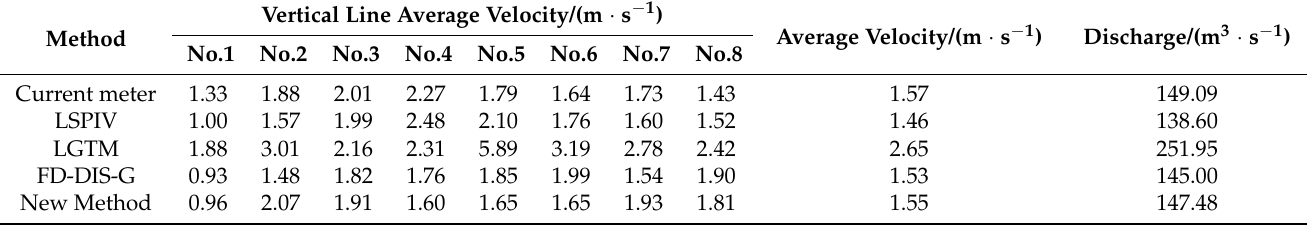
Table 5. Comparison of measurement results of five